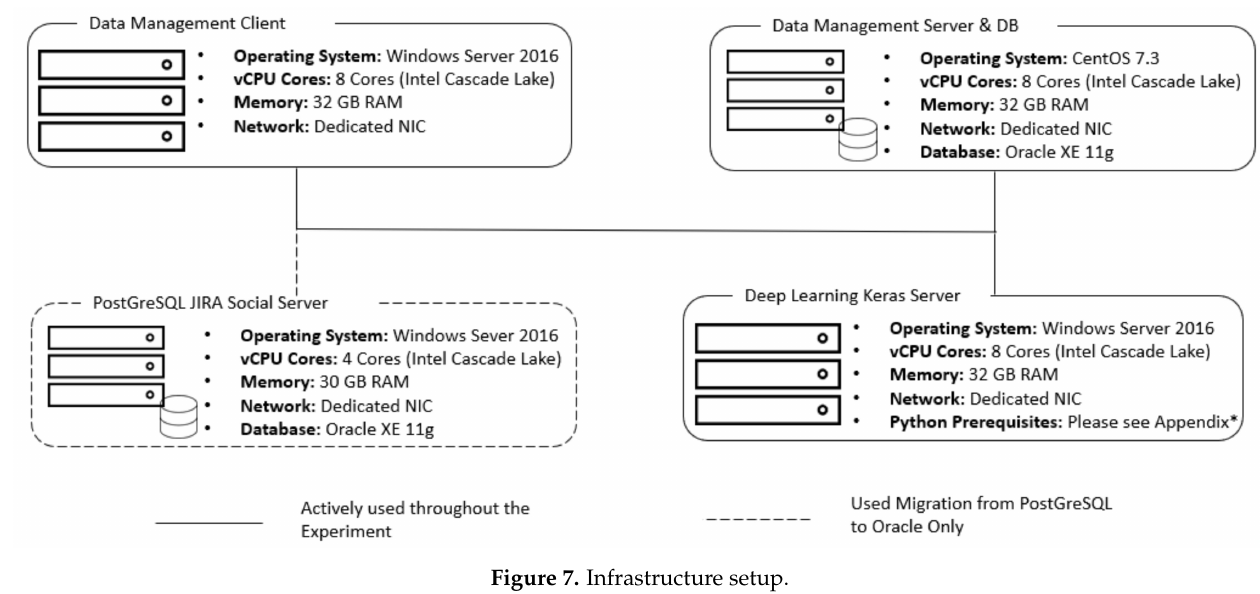
Figure 7. Infrastructure